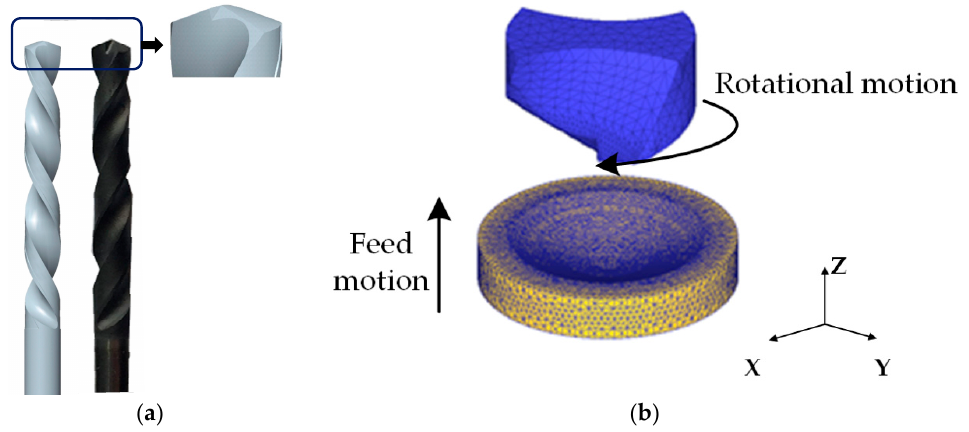
Figure 5. Drill modelling and simulation: ( a ) drill simplification; ( b ) FE modelling of drilling.